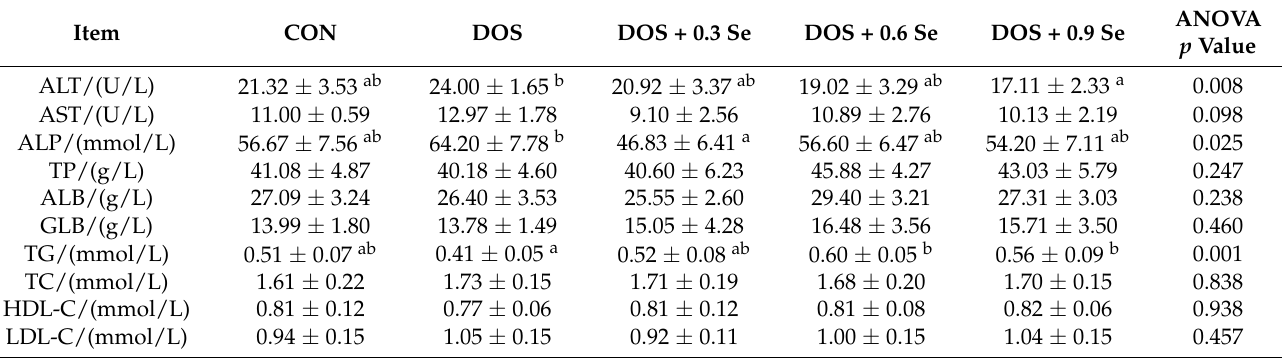
HDL-C, high density lipoprotein cholesterin. Results were shown as mean ± SD ( n = 6), different letters indicate ANOVA p value less than 0.05 which represent there is a significant difference between